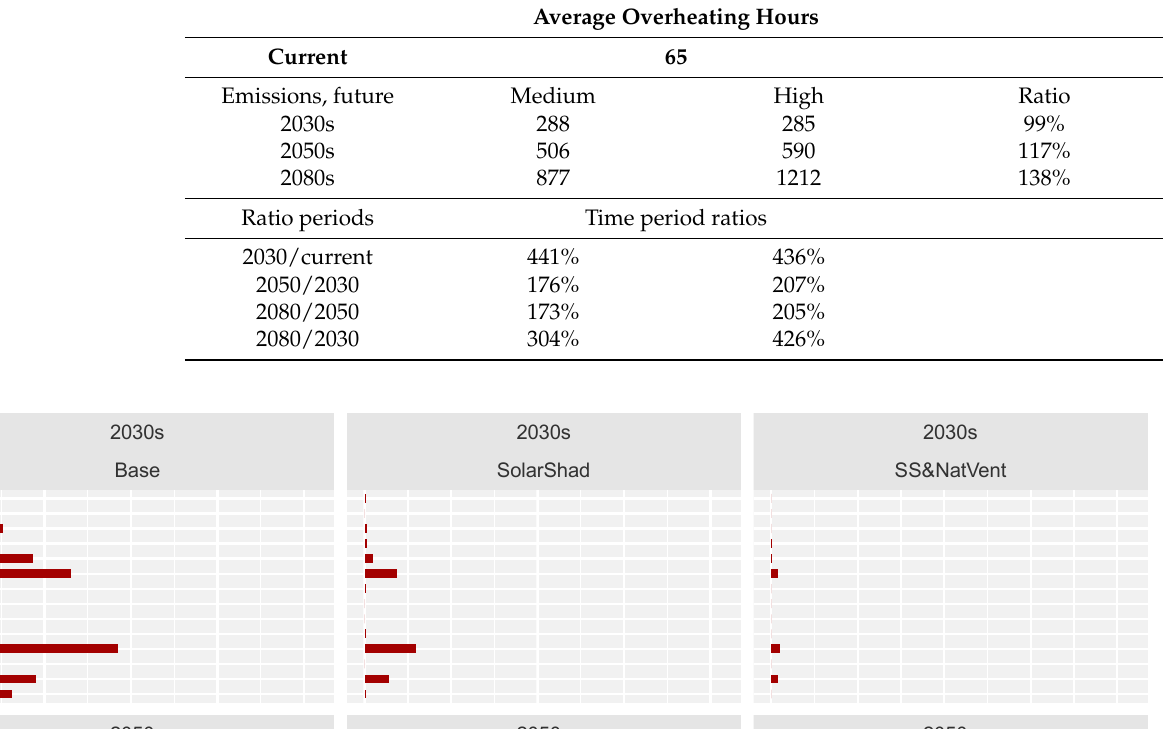
Table 9. Summary of average overheating hours between decades and emission scenarios.